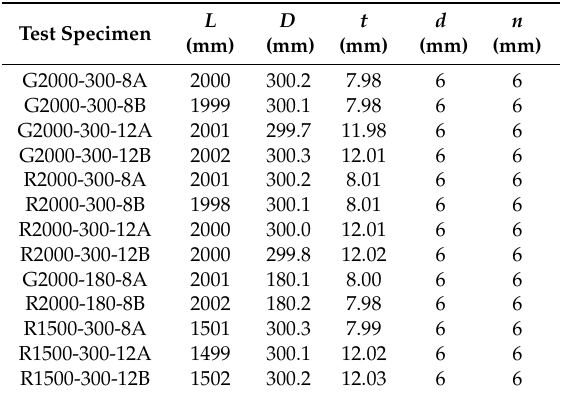
Table 2. Geometric size of test specimens.